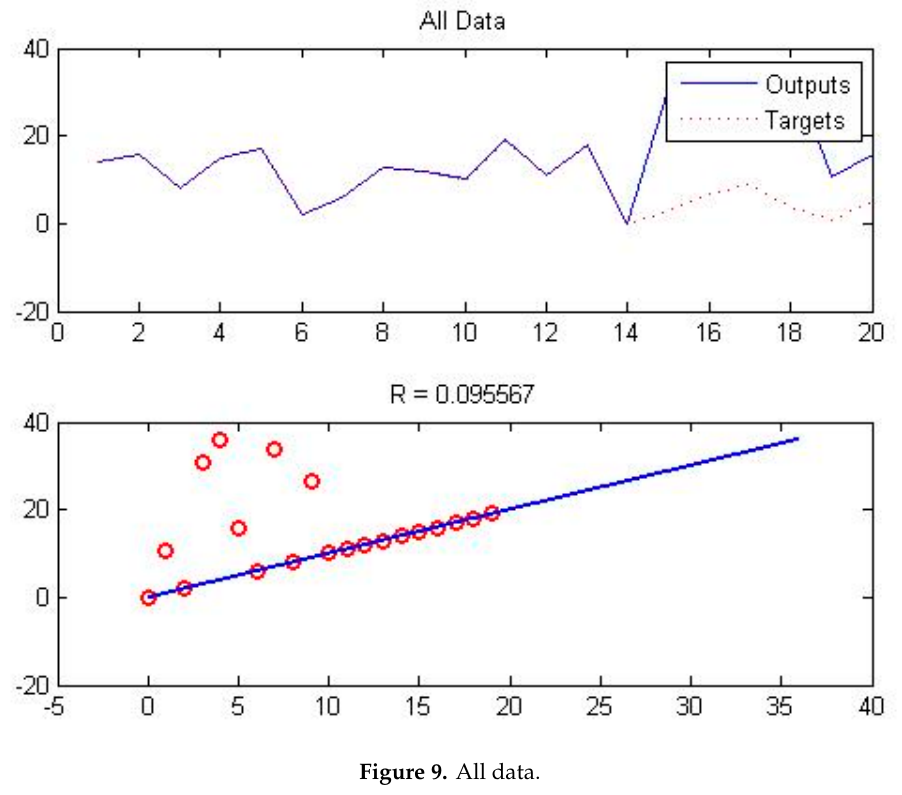
Figure 9. All data.